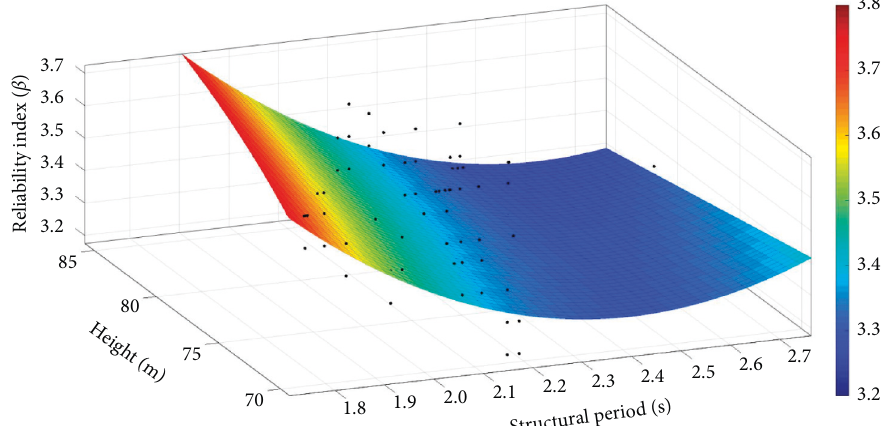
Figure 3: Reliability index vs structural vibration period and